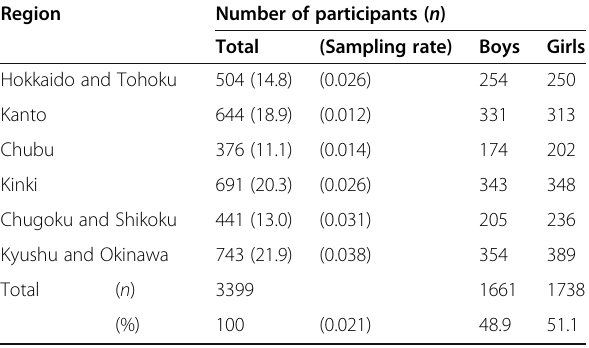
Table 2 Number of participants by region